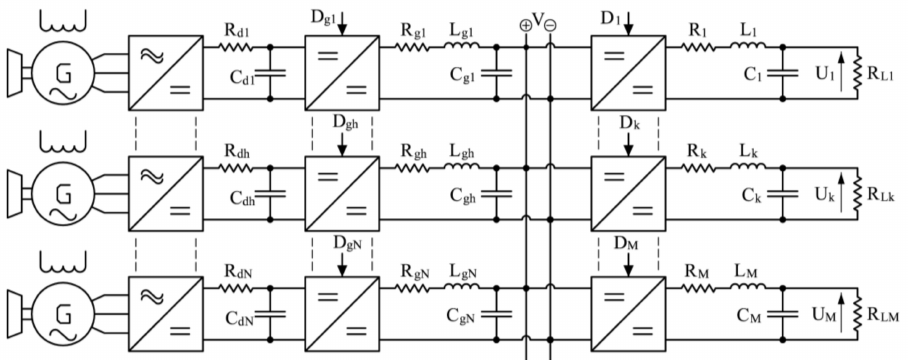
Figure 1. Complex DC Power System (radial topology, N generating systems, M controlled